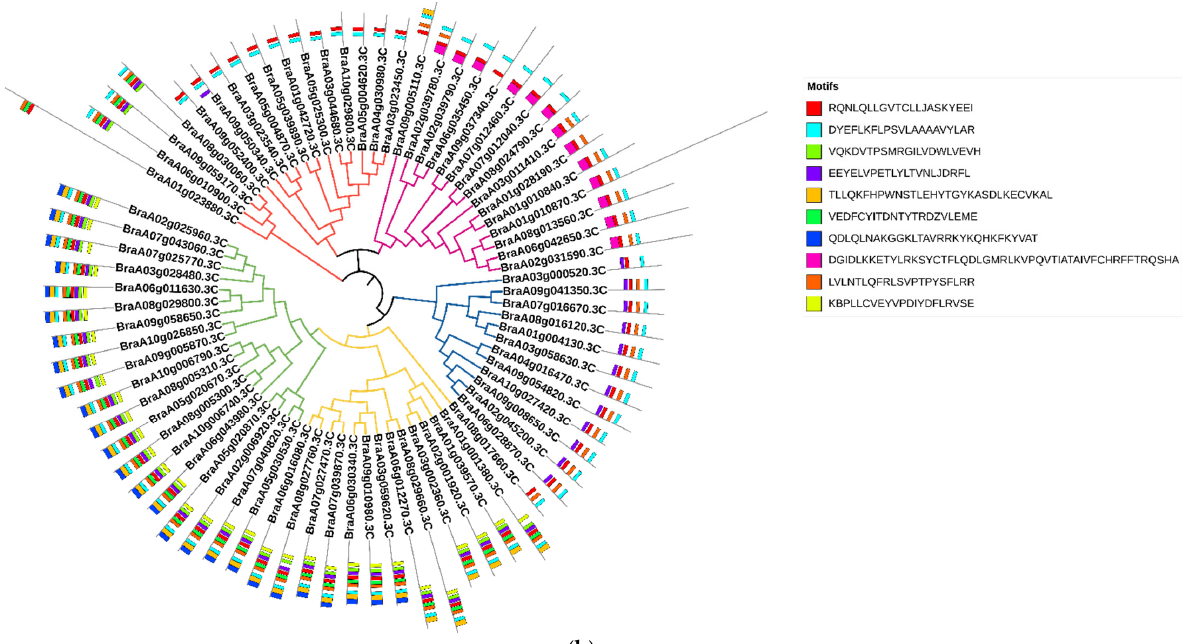
Figure 2. Graphical representation of the Brcyclin gene ( a ) Structure and ( b ) Conserved domain structures identified in the Brcyclins .